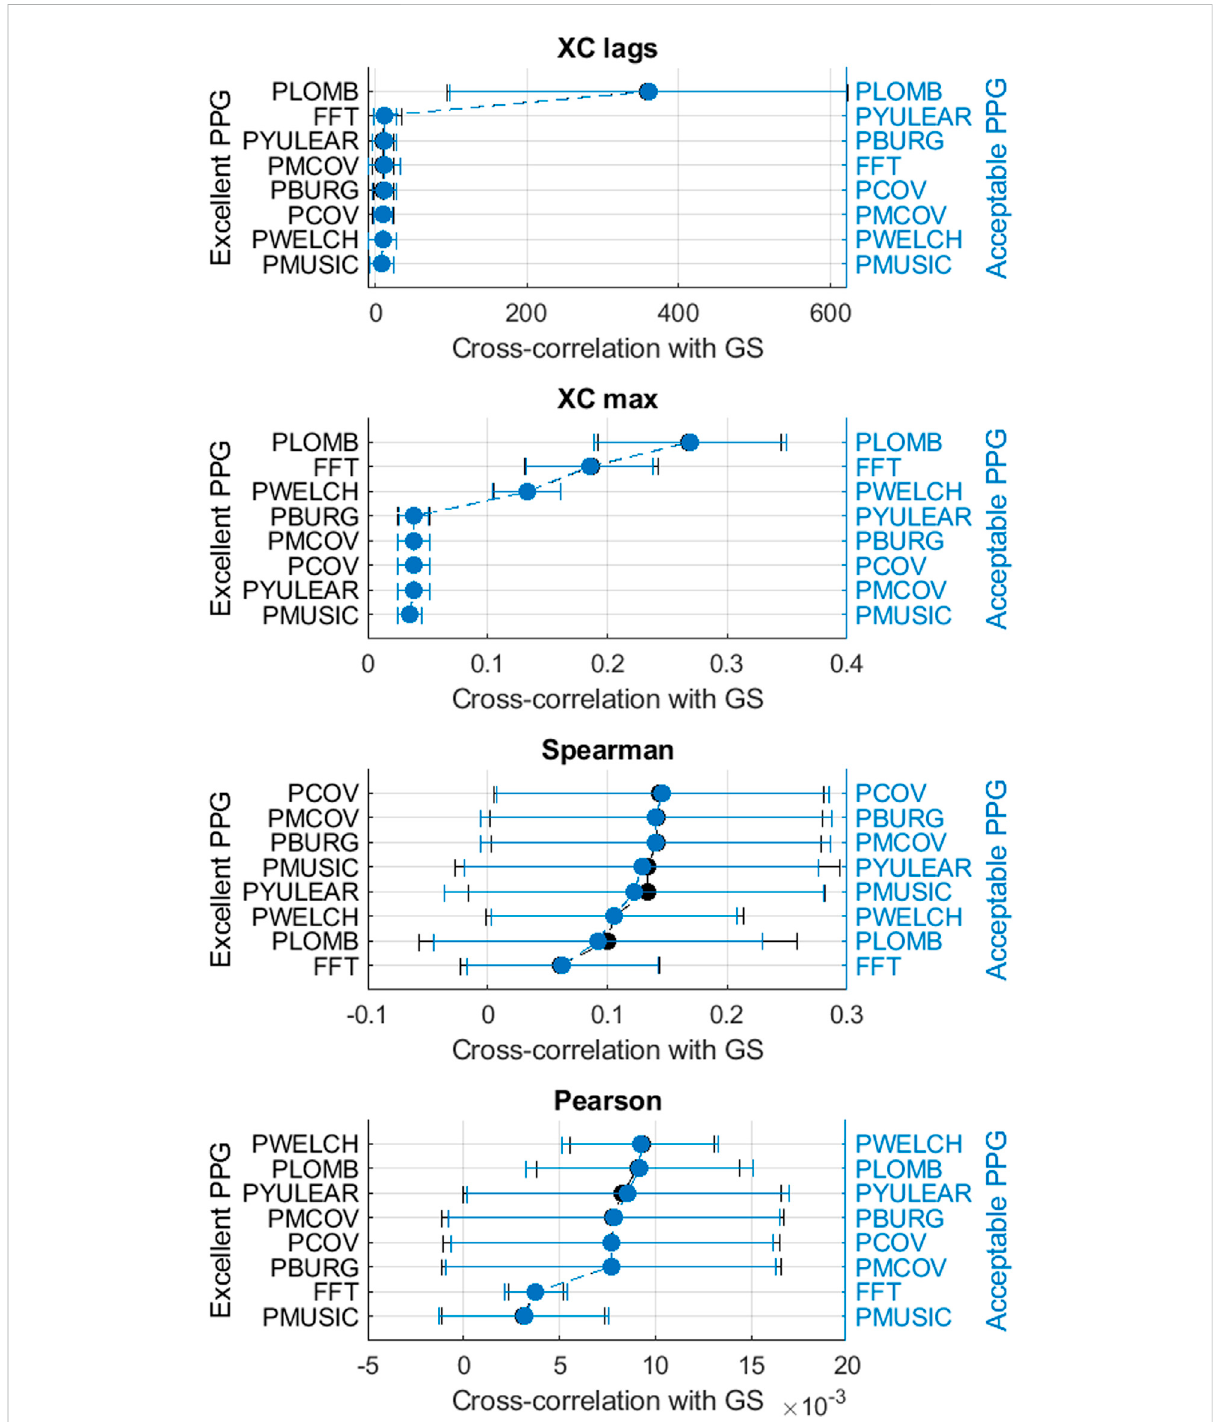
FIGURE 7 Mean and standard deviations of the correlation results obtained by comparing pulse rate variability spectra obtained from extracted and gold- standard